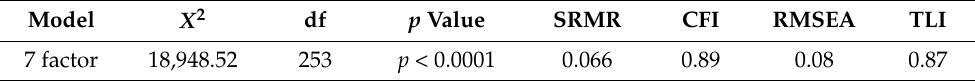
Table 5. Summary of fit indices.